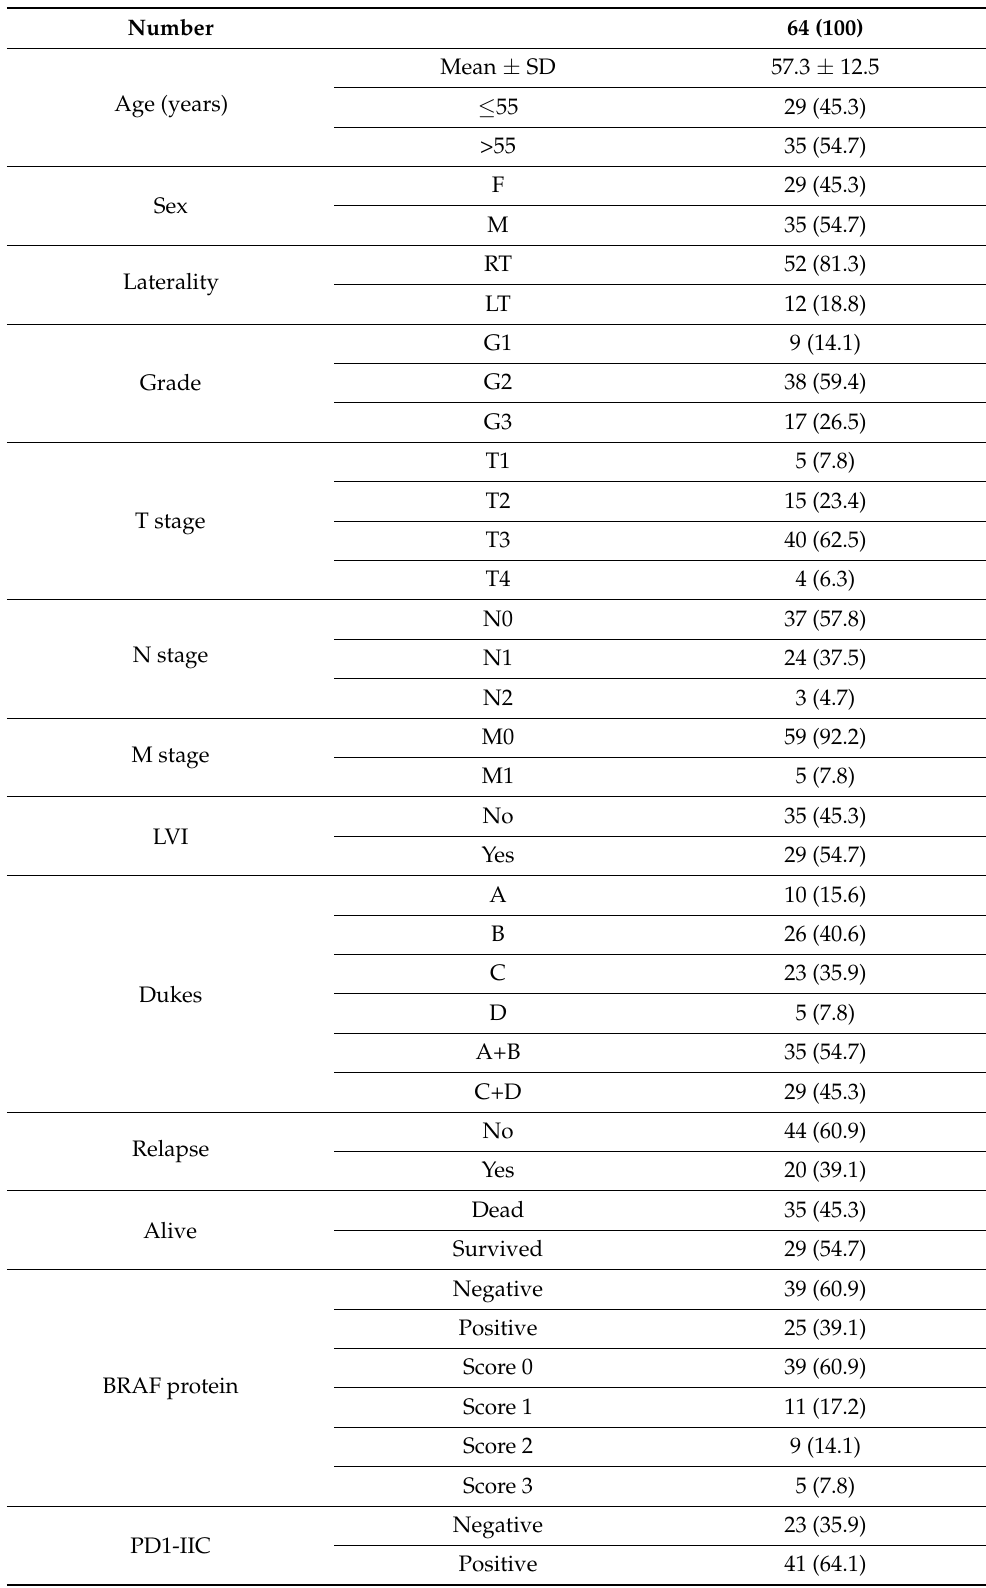
Table 1. The clinicopathological characteristics of the study